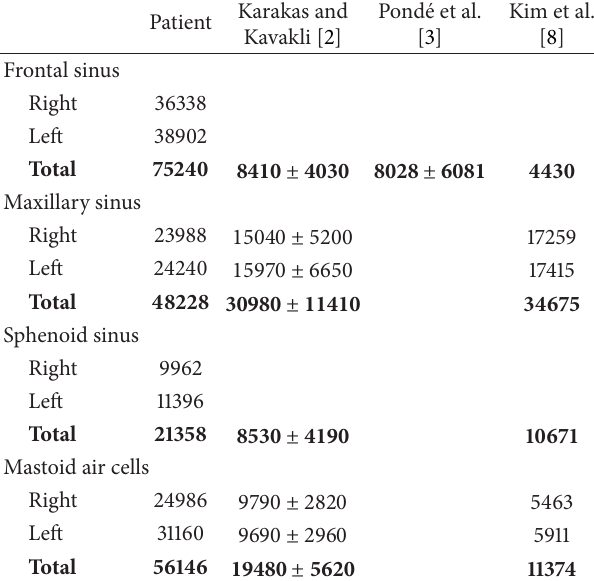
Table 2: Volume measurements (mm 3 ) of frontal, maxillary, and sphenoid sinuses and mastoid air cells.